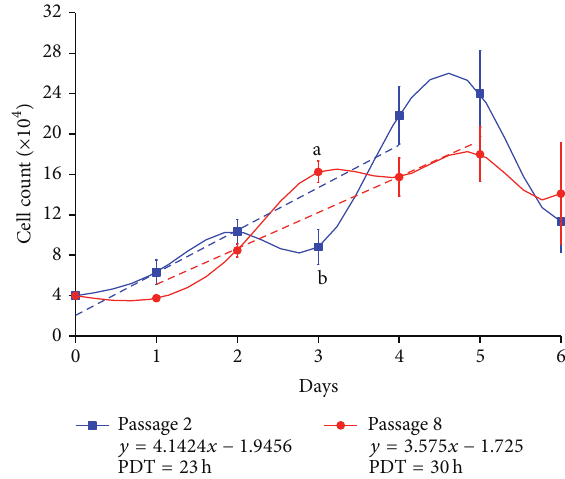
Figure 2: The growth curve of the second passage with initial density of approximately 4 × 10 4 and 5.5 × 10 4 cells per well of the Guinea pig fetal fibroblast cells ( 𝑛 = 3 fetuses and 3 counted wells/day/fetus; mean ± SE).